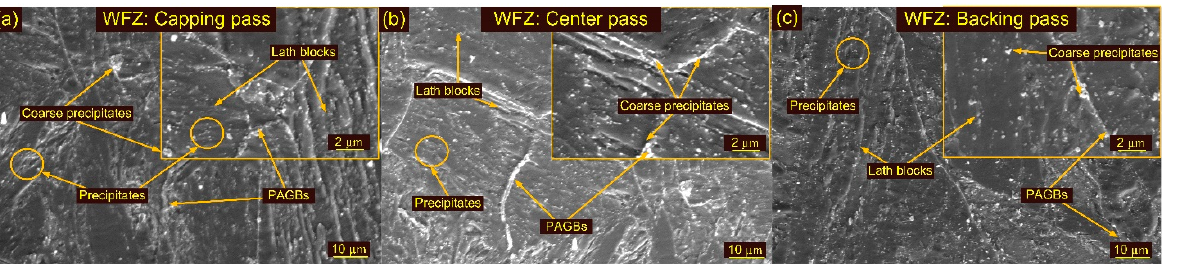
Figure 11. Weldments after T2 treatment: WFZ ( a ) capping pass, ( b ) center pass, ( c ) backing pass; ( d ) CGHAZ, ( e ) FGHAZ, ( f ) ICHAZ.